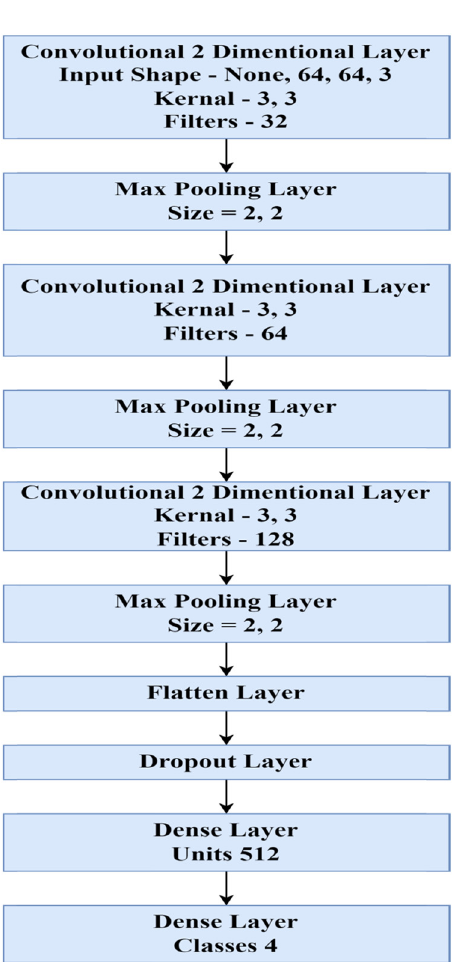
Figure 2: Schematic representation of the suggested technique.